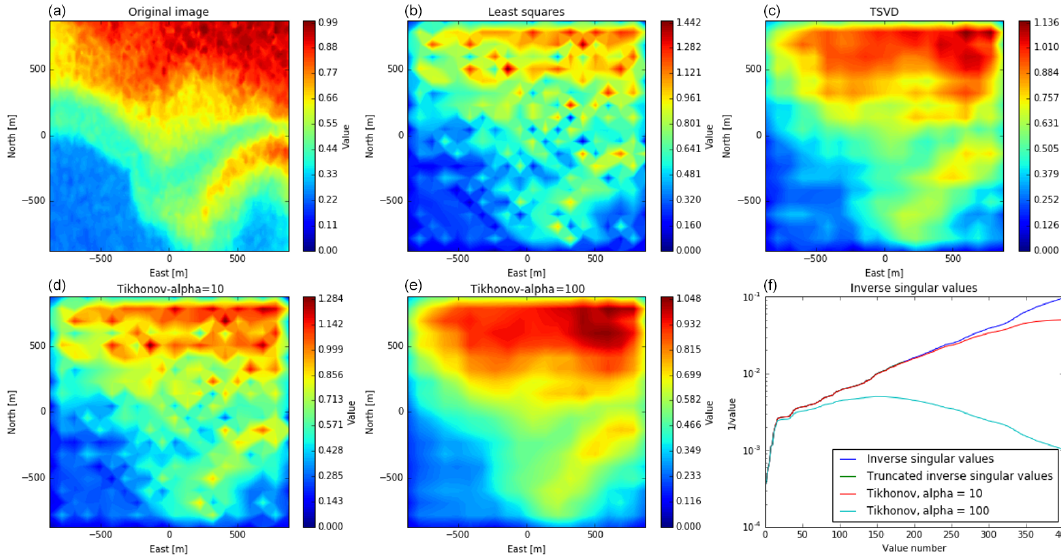
Figure 12. Comparison of reconstructions, using SVD for the MIMO case, including the outriggers. The plots correspond to Fig.